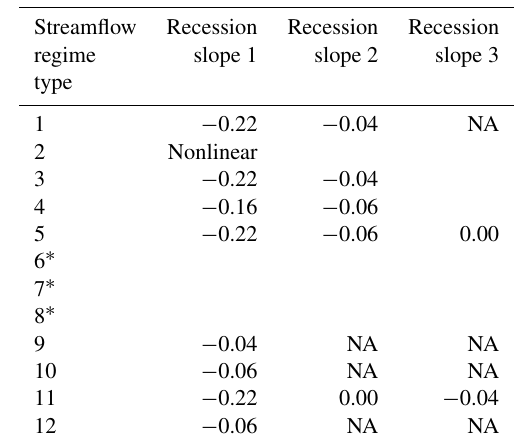
Table 4. Summary of recession slopes amongst the 12 Stream- flow Regime Types. Units are z -score/length estimated from Fig. 8. Types with ∗ have only one member and are excluded here. NA means not